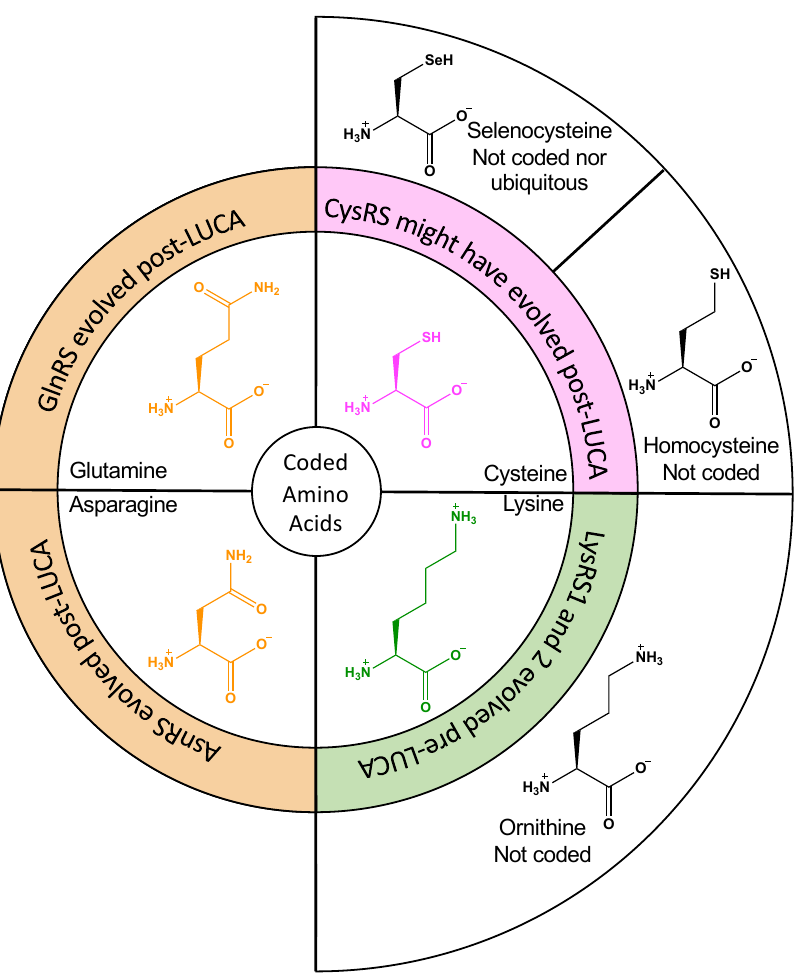
Figure 1. Connections between aaRS evolutionary events and amino acid substrates. Amino acid chemistry might explain idiosyncrasies in the evolution of AsnRS, GlnRS, CysRS, and LysRS. The central ring shows the amino acid substrates for these aaRSs. LysRS existed in two evolutionarily distinct forms (LysRS1 and LysRS2, green) in LUCA; CysRS is missing from some methanogenic archaea and might have been fixated post-LUCA (magenta); GlnRS and AsnRS clearly emerged post-LUCA and are still missing in many microorganisms. The outer circle shows structurally similar amino acids that were available metabolically but were rejected from the genetic code (ornithine and homocysteine) or entered the code post-LUCA